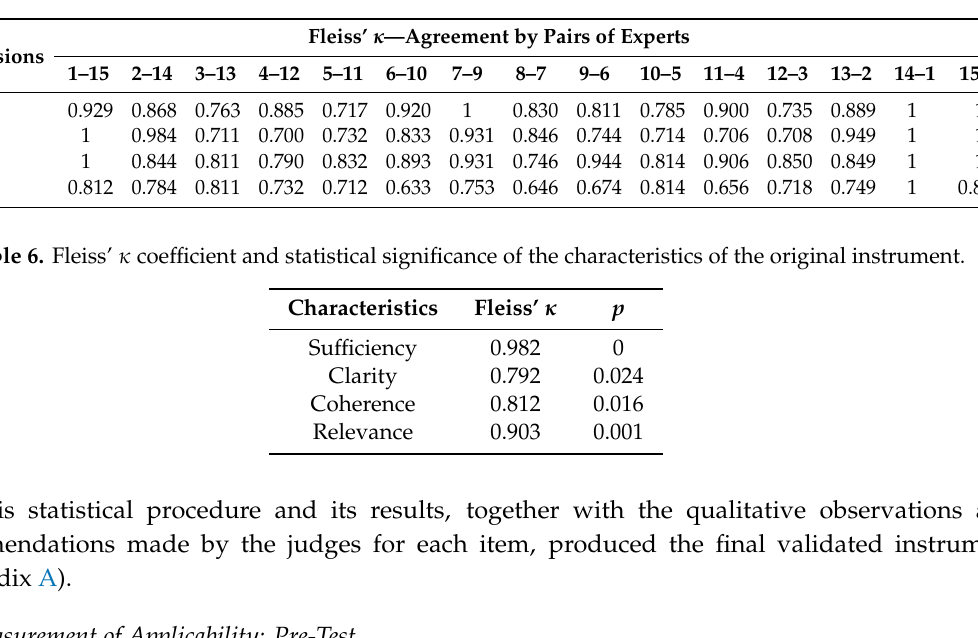
Table 5. Agreement by pairs of experts.